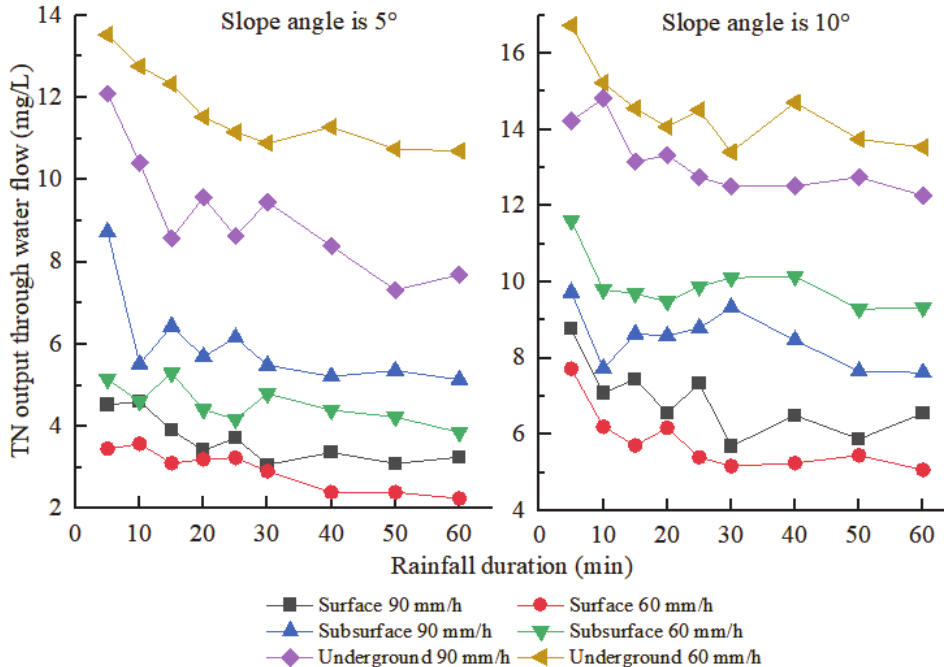
Figure 4. Variation of TN concentration in Karst slope farmland with time.